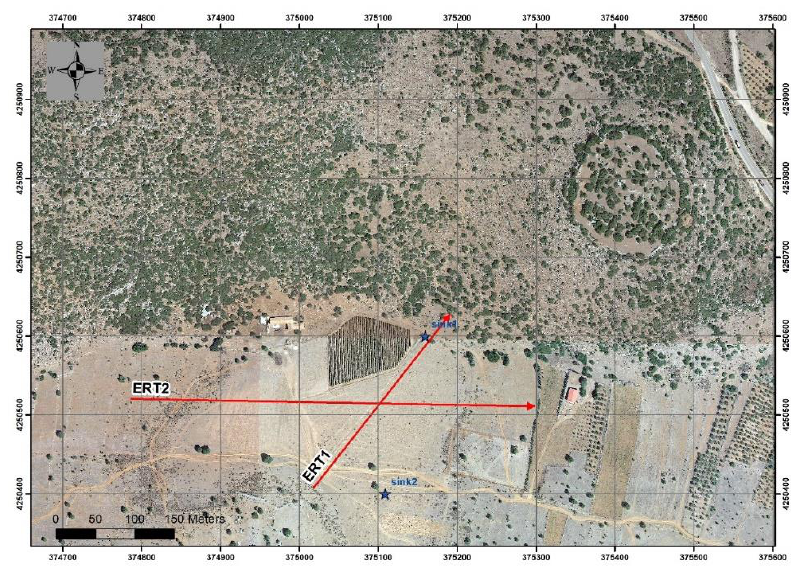
Figure 4. Aerial view of Kastrouli (round circle) and environment with the two ERT traverses (in red). The two sinkholes sink1, sink2 are shown in blue stars. The traced, shaded landmark on the edge of the plain is noticeable, and it is where water gathers during the winter; this geometric mark indicates plant debris forming a traced boundary of a littoral zone. Axis numbers are the HGS (Hellenic Geodetic System) 1987 coordinates in meters.